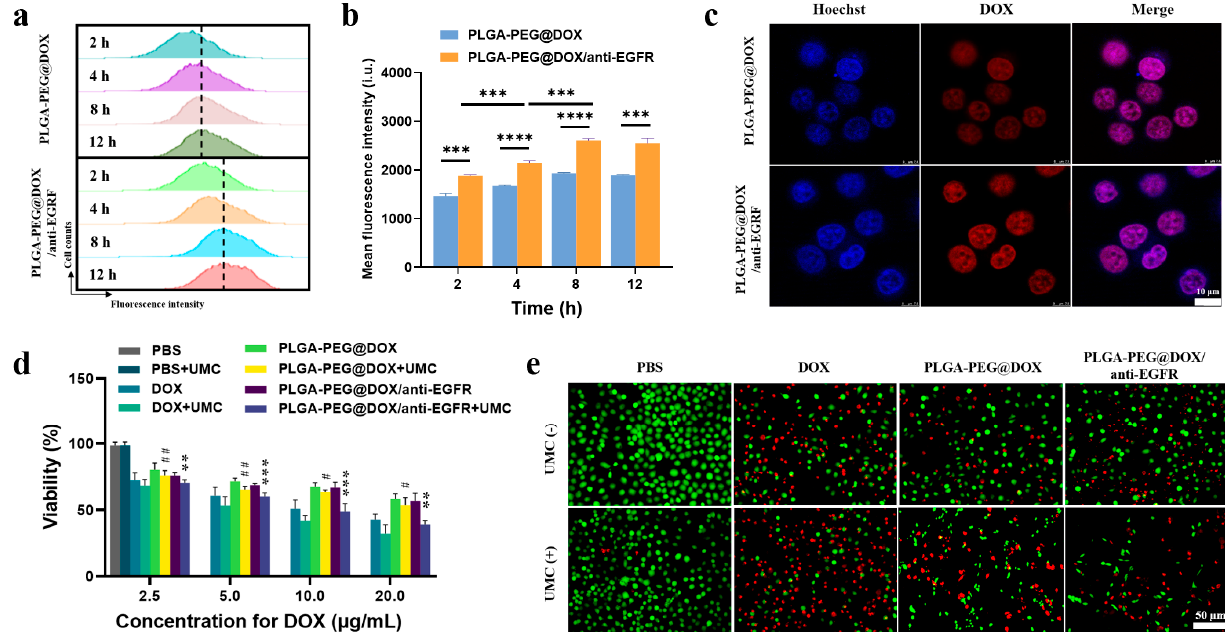
Figure 3. Flow cytometry ( a ) and corresponding mean fluorescence intensity values ( b ) for MDA-MB-468 cells following treatment with PLGA-PEG@DOX or PLGA-PEG@DOX/anti-EGFR nano-micelles (5 µg/mL DOX equivalent dose) for the indicated amounts of time ( n = 3). *** p < 0.001, **** p < 0.0001. ( c ) MDA-MB-468 cells were assessed via confocal microscope following an 8 h treatment with PLGA-PEG@DOX/anti-EGFR nano-micelles (5 µg/mL DOX equivalent dose). Scale bar: